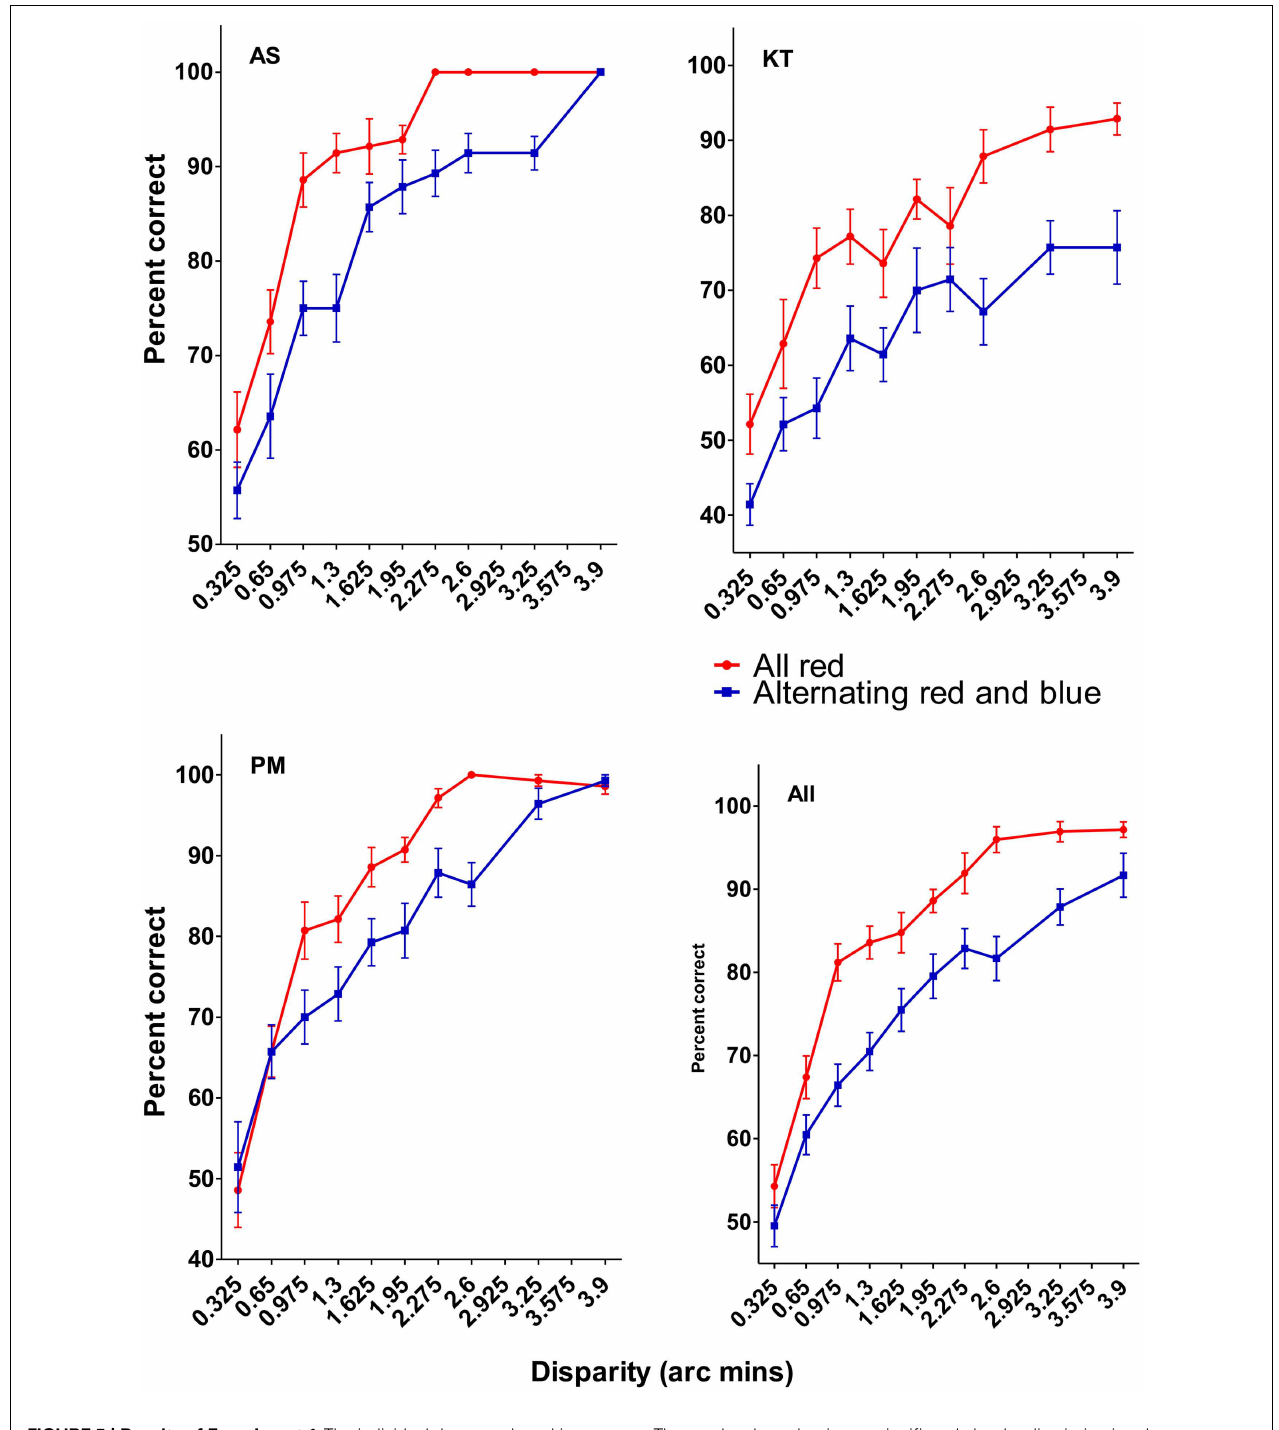
FIGURE 5 | Results of Experiment 1. The individual data are plotted in the top two and bottom left figures, and the average data is plotted on the bottom right. Error bars in this and all subsequent figures are